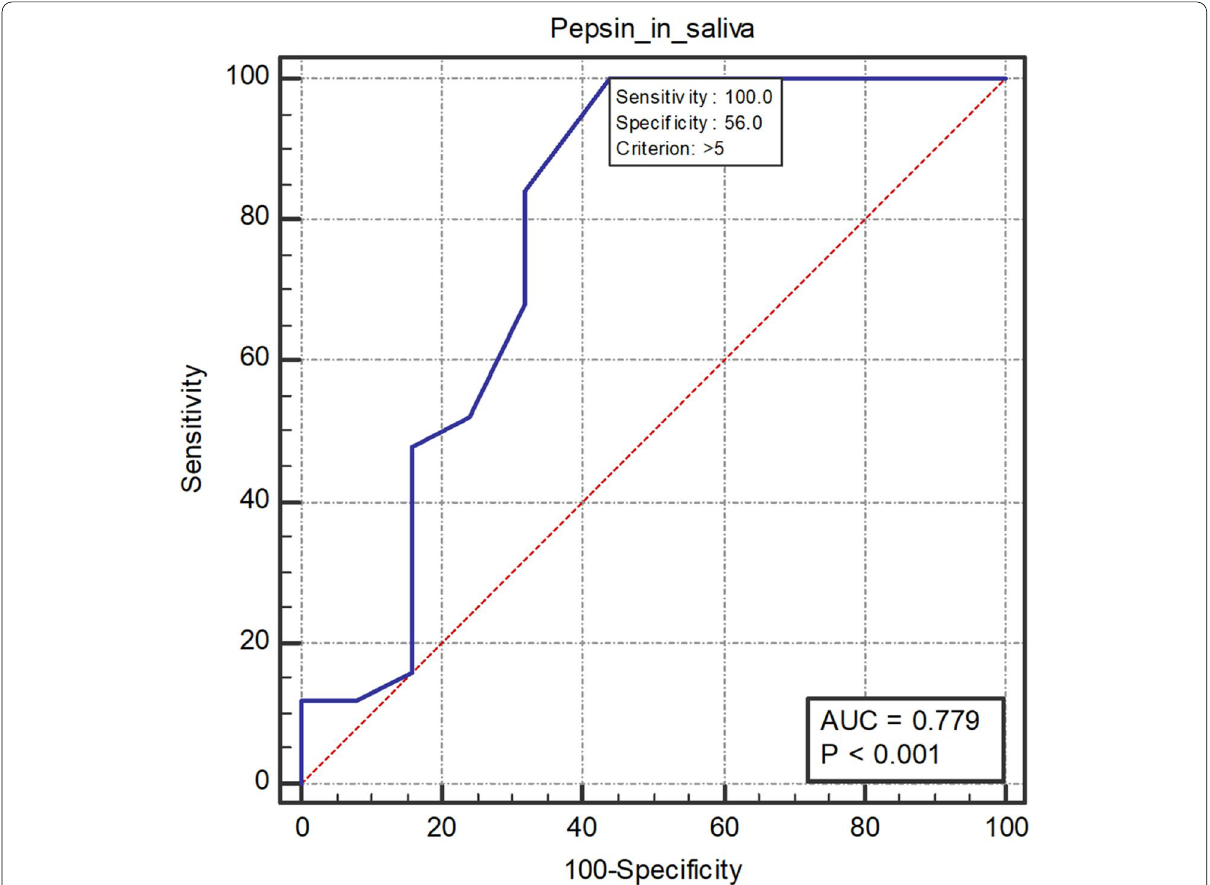
Fig. 3 ROC curve for salivary pepsin